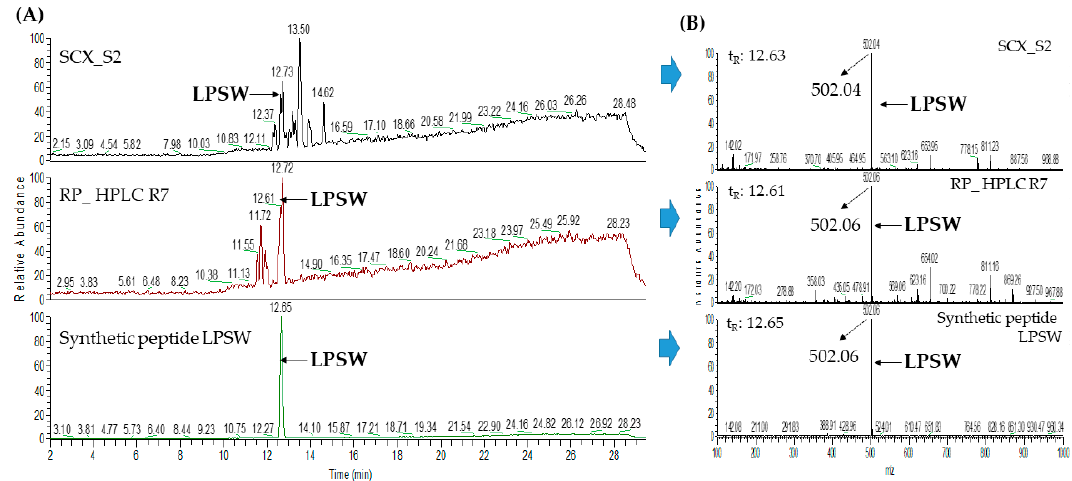
Figure A6. ( A ) LC–MS chromatograms of SCX S2, RP R13, and the synthetic peptide LVGLPL, ( B ) MS spectra of LVGLPL originated from fraction SCX S2 ( m / z 611.19, tR 13.71 min), fraction RP R13 ( m / z 611.19, tR 13.69) and synthetic LVGLPL ( m / z 611.19, tR 13.79).